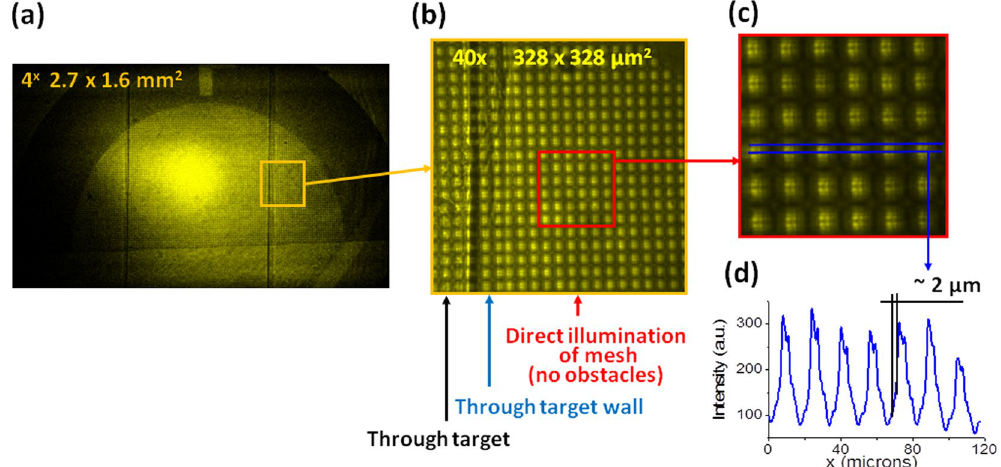
Figure 4. The image of 1500 lpi mesh obtained on LiF for the evaluation of an instrumental spatial resolution: Panel (a) contains a large field of view photoluminescent image, observed with a 4X microscope objective. Panel (b) shows part of the full image with different elements of target, observed with objective 40X, while panel (c) shows an enlarged crop of this image, in which the diffraction pattern in open areas of the mesh is clearly seen. Panel (d) contains an intensity profile taken from the cropped